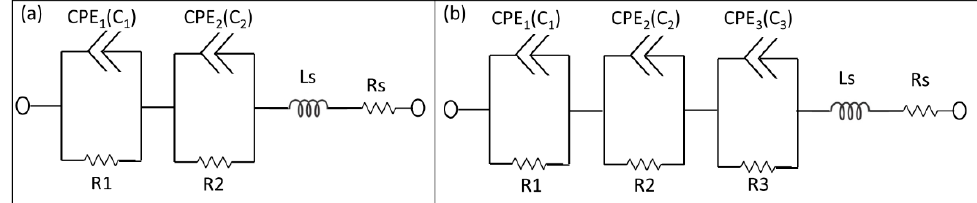
Figure 3. Electrical equivalent circuits used to model impedance spectra of the biochips ( a ) before (two pairs of constant phase elements (CPEs) and resistors) and ( b ) after inserting analyte into the ring electrode (3 pairs of CPEs and resistor). The equivalent circuit parameters Ls and Rs represent the interface properties of the circuit wiring.